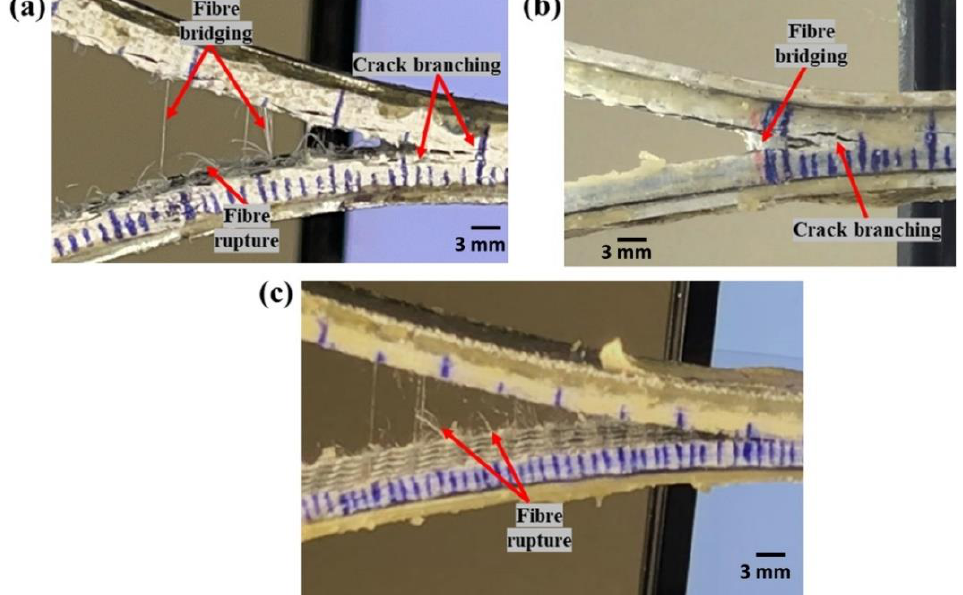
Figure 11 . Macro-photographs of side surfaces of ( a , b ) Carbon_UHMWPP and ( c ) Carbon_UHMWPE reinforced thermoplastic composites .